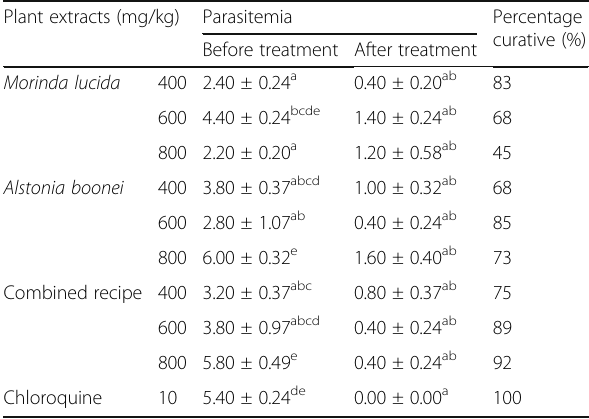
Table 4 Comparative antiplasmodial activity of Morinda lucida , Alstonia boonei , the combined recipe of plant extracts and chloroquine (a standard drug) to 10 mg/kg against P. berghei Plant extracts (mg/kg) Parasitemia Percentage curative (%) Before treatment After treatment Morinda